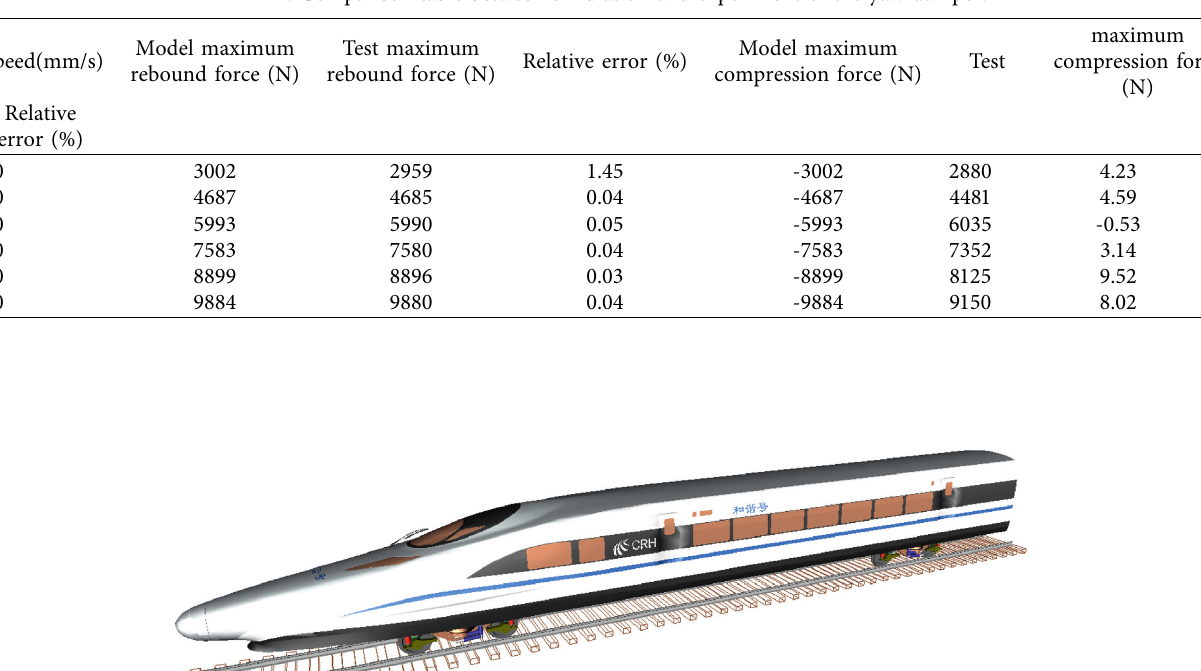
Figure 5: Indicator diagram comparison of the model and test of the yaw damper. (a) Model indicator diagram. (b) Test indicator diagram. Table 1: Comparison table between simulation and experiment of the yaw damper.